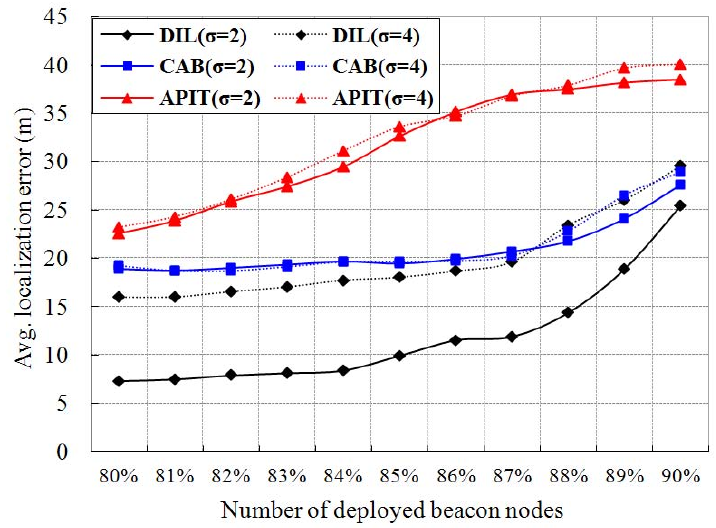
Figure 13. Comparison of average estimated localization error for different standard